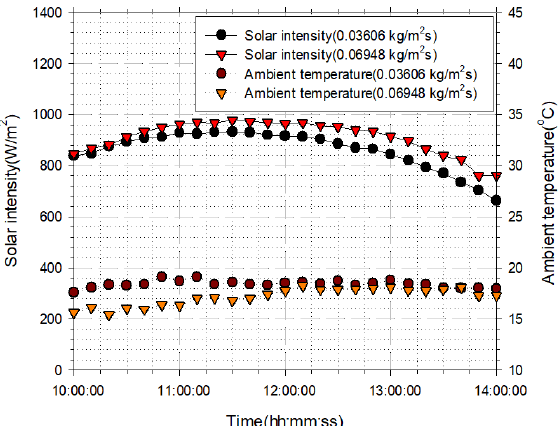
Figure 5. The solar intensity and ambient temperature during the test period for each day.